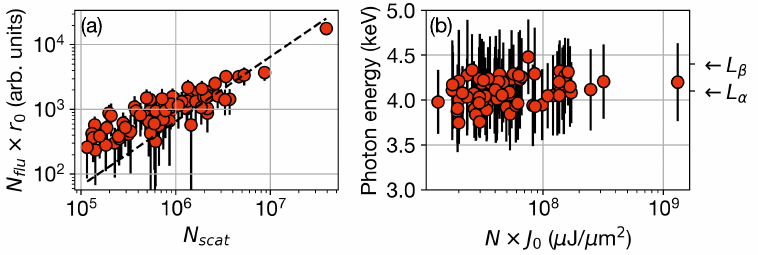
Figure 4. Correlation maps between the observables obtained from fluorescence spectrum and small-angle X-ray scattering (SAXS). ( a ) Correlation between the number of scattered photons detected by the octal MPCCD and fluorescence photons detected by one of the two single MPCCD sensors. The black dotted line is a guide representing N flu × r 0 ∝ N scat . ( b ) Correlation between the X-ray dose (=cluster size × XFEL fluence) and the photon energy of fluorescence. The positions of the photon energies of Xe atomic L α and L β fluorescence are shown to the right side of ( b ). The error bars shown in both ( a , b ) are composed of the statistical errors of the number of fluorescence